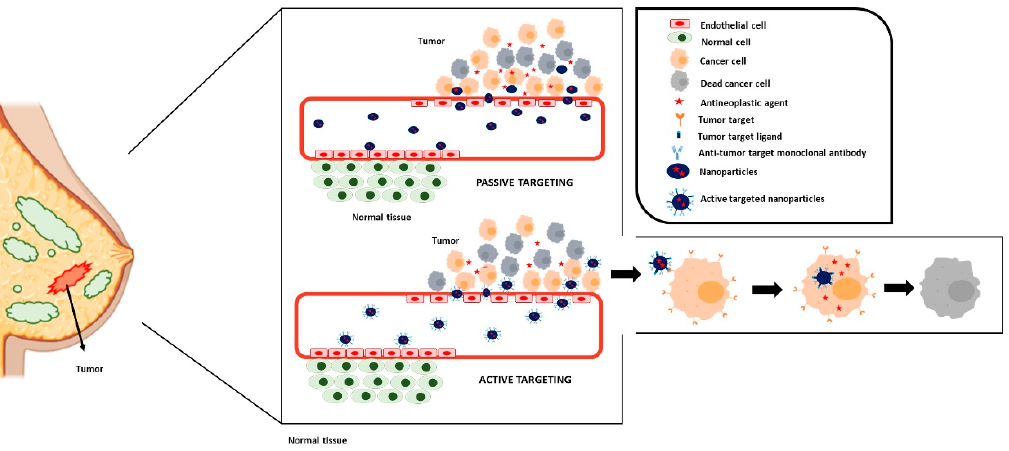
Figure 3. Scheme of passive and active targeting strategies. In passive targeting strategy, nanomedicines tend to accumulate at tumors due to EPR effect. In active targeting strategy, a ligand whose receptor is solely expressed or overexpressed at tumor cells is incorporated in nanomedicines. This ligand binds its receptor, and nanomedicines are selectively internalized by tumor cells.